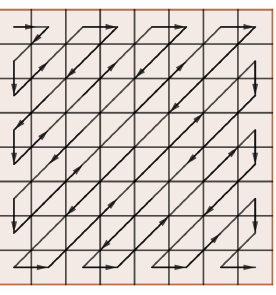
Figure 4. Path followed in a matrix to transform it into a vector via Z